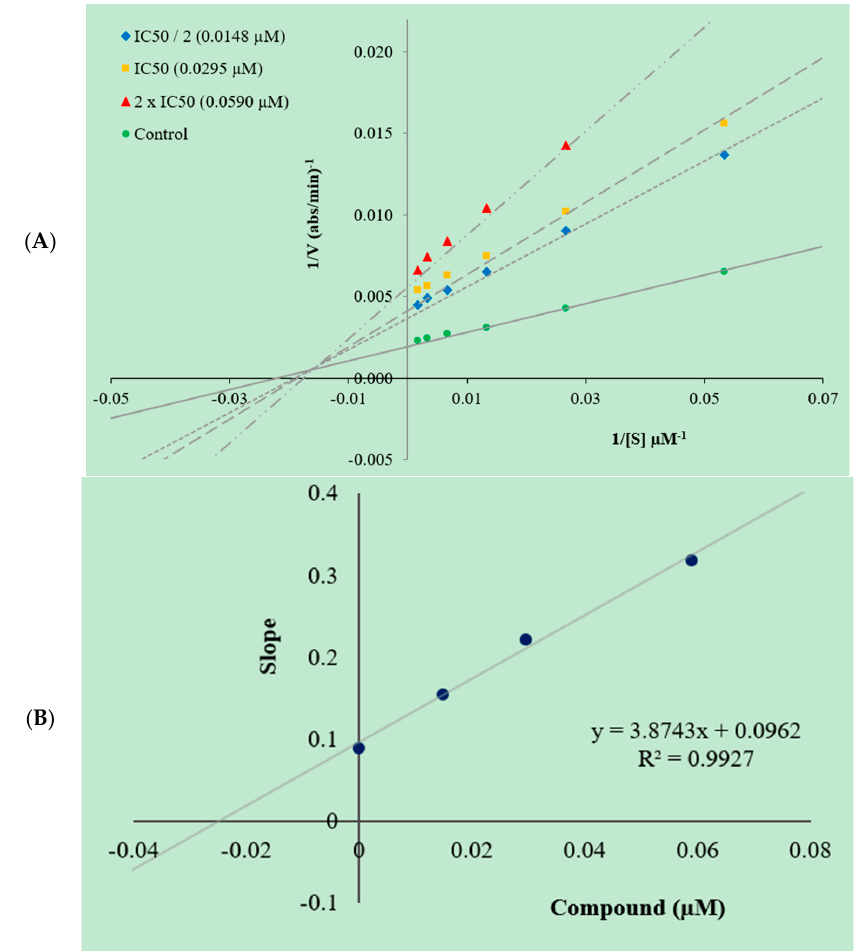
Figure 2. ( A ) Lineweaver-Burk plots for the inhibition of AChE by compound 3h . [S], substrate concentration ( µ M); V, reaction velocity (abs/min) − 1 . ( B ) Secondary plot for calculation of steady-state inhibition constant (K i ) of compound 3h . K i was calculated as 0.0248 µM.